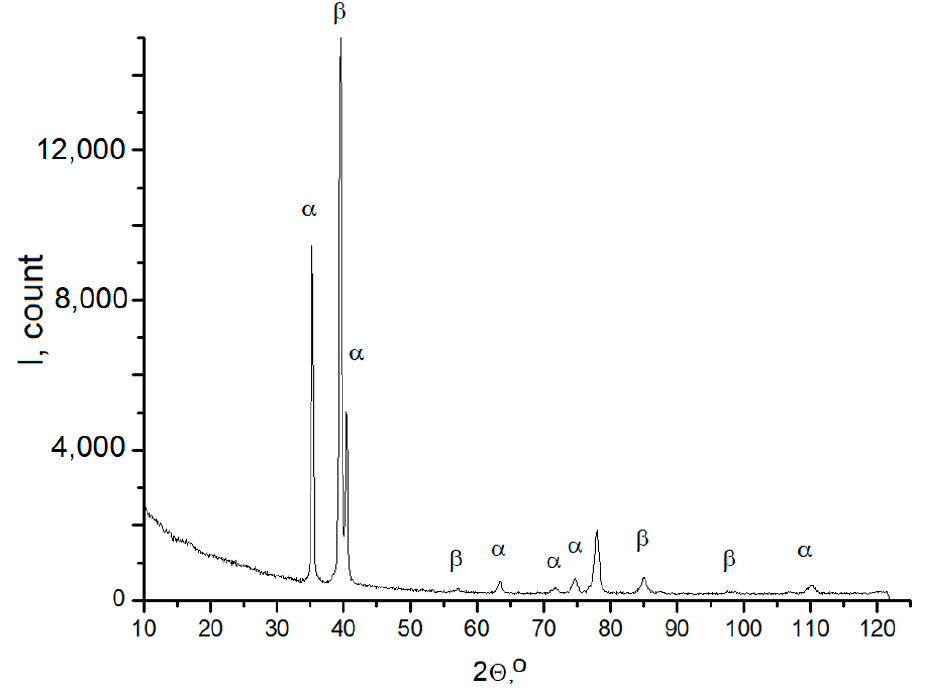
Figure 9. X-ray di ff raction of sample 6 of Ti-Al-Mo-V alloy (see Figure Figure 9. X-ray diffraction of sample 6 of Ti-Al-Mo-V alloy (see Figure 1). Figure 9. X-ray diffraction of sample 6 of Ti-Al-Mo-V alloy (see Figure 1).